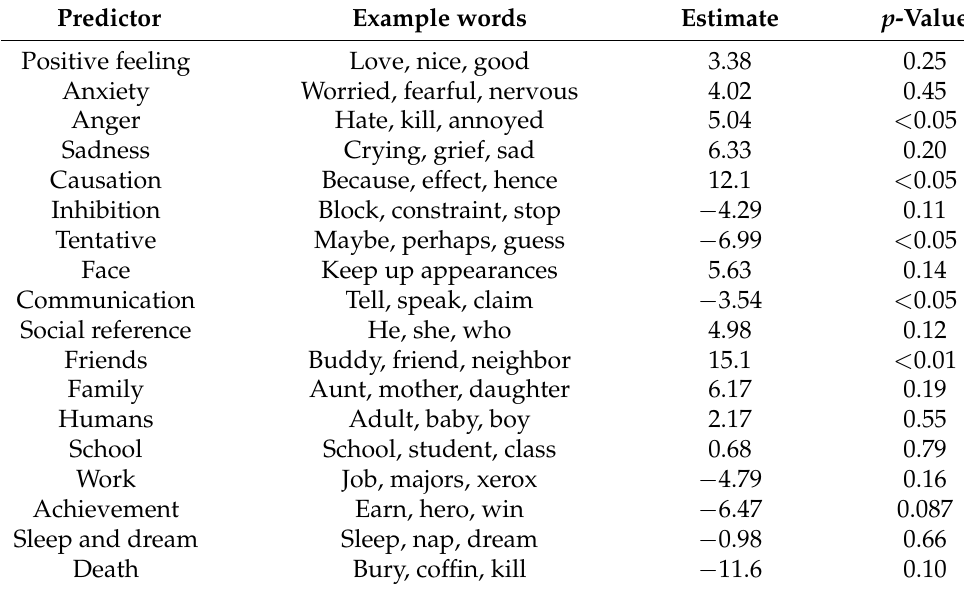
Table 3. Results of regression models for predicting CES-D scores. Table extracted from